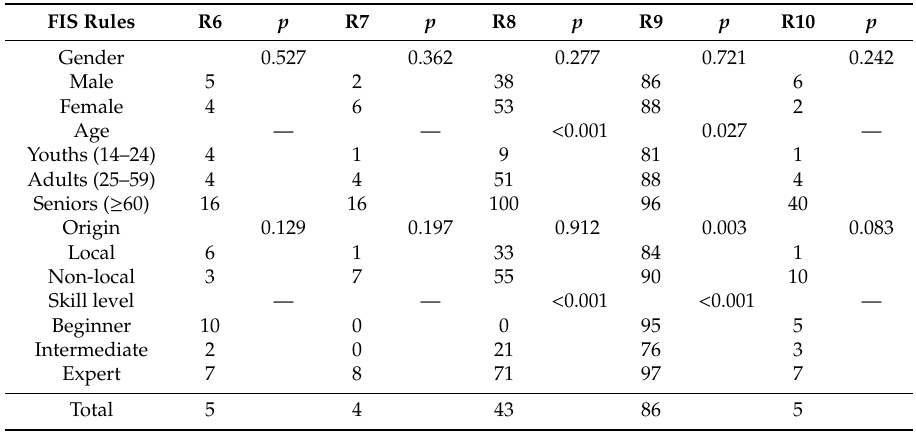
Table 7. Active knowledge of existing rules (*).